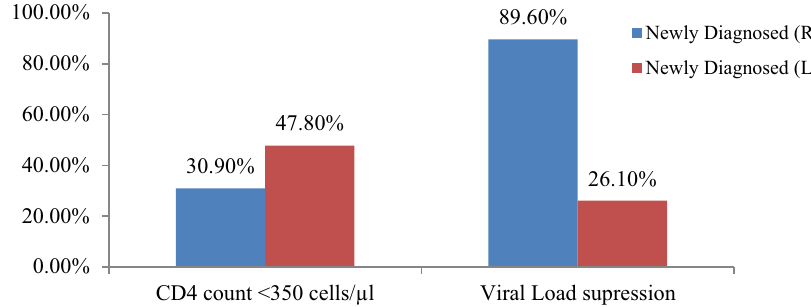
Fig. 3 Stages of HIV disease among PLHIV who were newly diagnosed recent and long-term